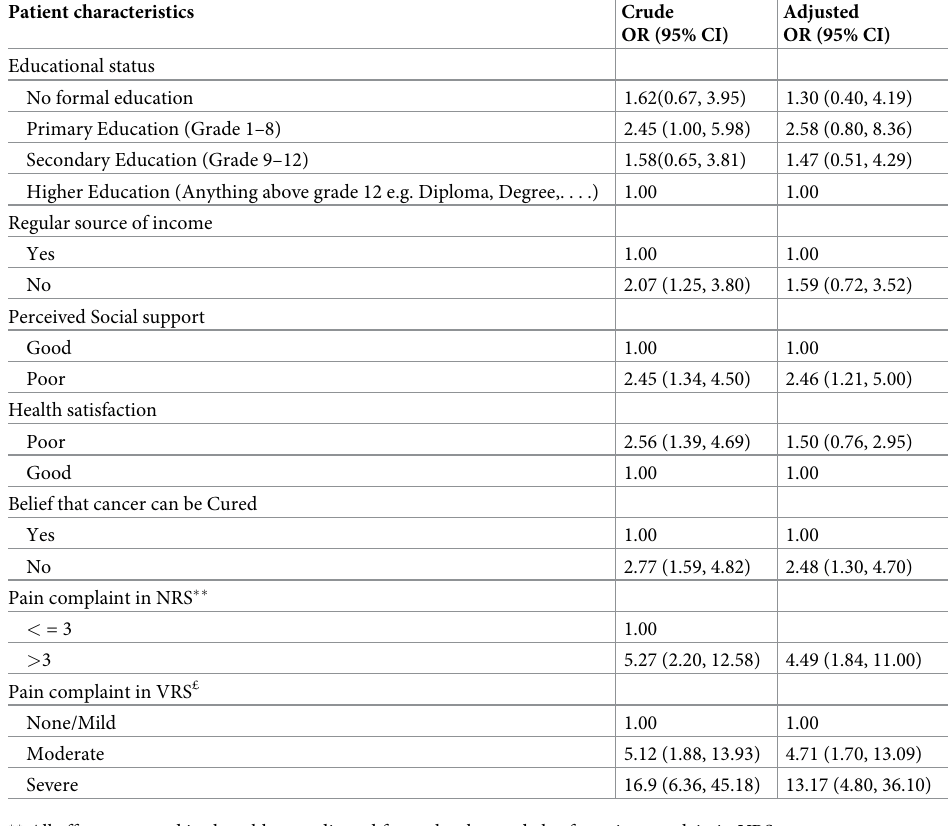
Table 5. Fully adjusted effects of selected socio-demographic and clinical characteristics on the odds of being depressed. Patient